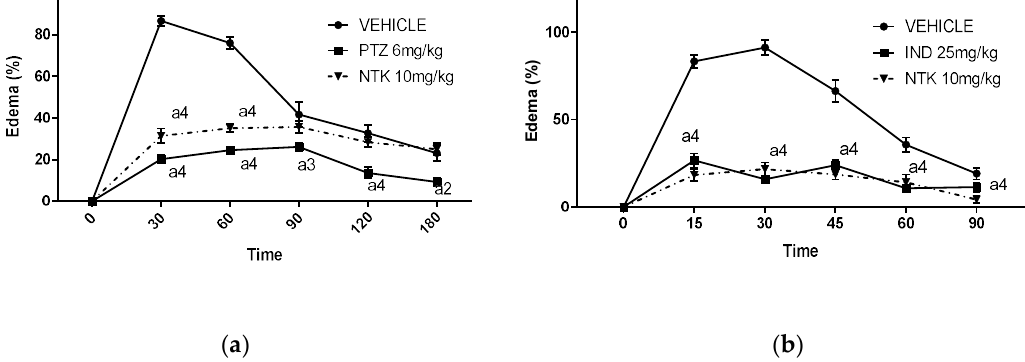
Figure 3. Potential mechanisms associated with NTK-mediated paw edema inhibition. The antiedematogenic effect is expressed as a percentage of edema induced by histamine ( a ) or arachidonic acid ( b ). a4 = p < 0.0001 vs. saline; a3 = p < 0.001 vs. saline and a2 = p < 0.01 vs. saline. Statistical significance was determined with two-way ANOVA and post hoc Tukey test.